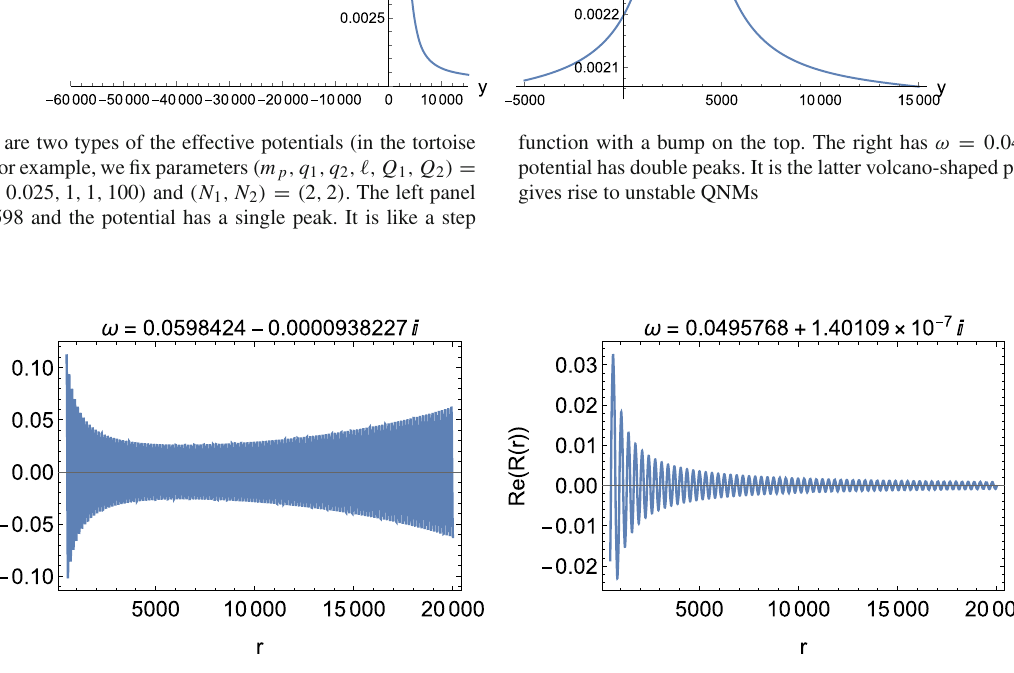
( 0 . 045 , 0 . 025 , 0 . 025 , 1 , 1 , 100 ) . When ω = 0 . 0598, the